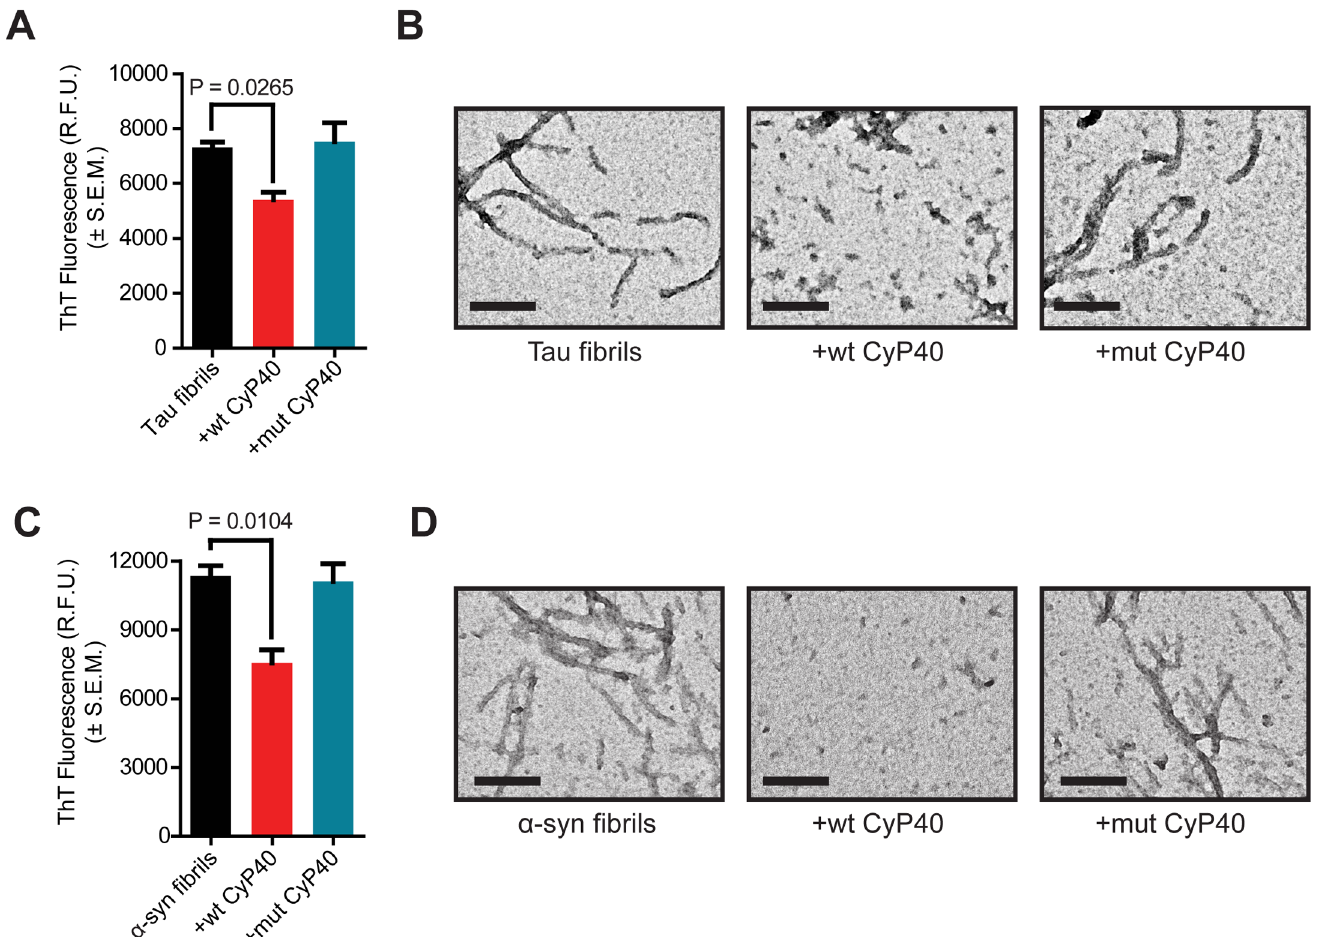
Fig 7. Cyclophilin 40 (CyP40)-mediated disaggregation assay of wild-type (wt) and peptidyl-prolyl isomerase (PPIase) null mutant (mut) CyP40. (A) ThioflavinT (ThT) fluorescence of tau ± wt CyP40 or mut CyP40 (unpaired t test, n = 3 for each condition). (B) Representative transmission electron microscopy (TEM) images of (A) (scale bar 200 nm). (C) ThT fluorescence of A53T α -synuclein( α -syn) ± wt CyP40 or mut CyP40 (unpaired t test, n = 3 for each condition).(D) Representative TEM images of (C) (scale bar 200 nm). The numerical data used in panels7A and 7C can be found in S1 Data. RFU, relativefluorescence unit; SEM, standard error of the mean.